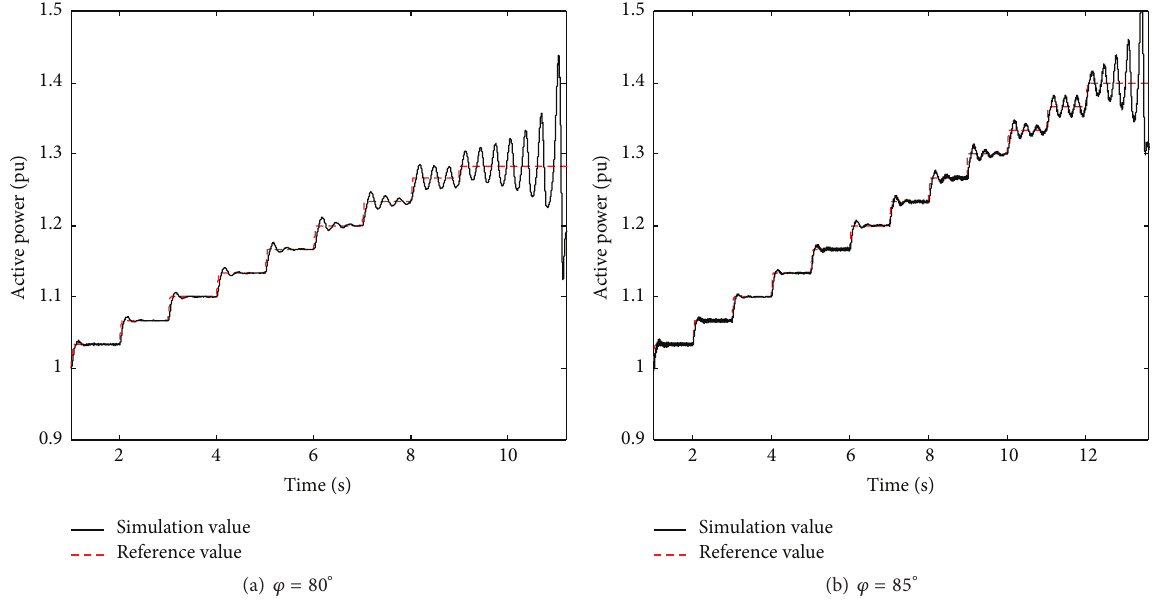
Figure 9: Maximum power transmission with different impedance angles (rectifying operation).